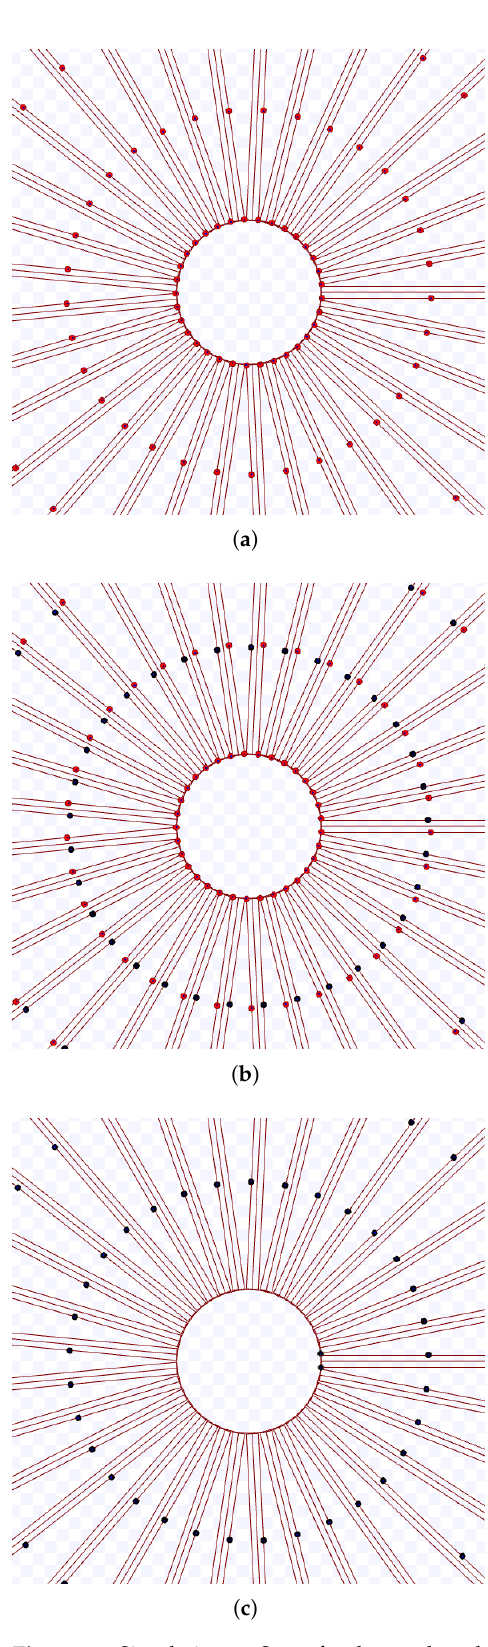
Figure 39. Simulation on Stage for the touch and run strategy using s = 6 m, K = 33 during T = 548 s at v = 0.1 m/s. Available on https://youtu.be/-xZz84npKV4, accessed on 12 June 2022. ( a ) 0 s: beginning of the simulation; ( b ) After 274 s; ( c ) 548 s: ending of the